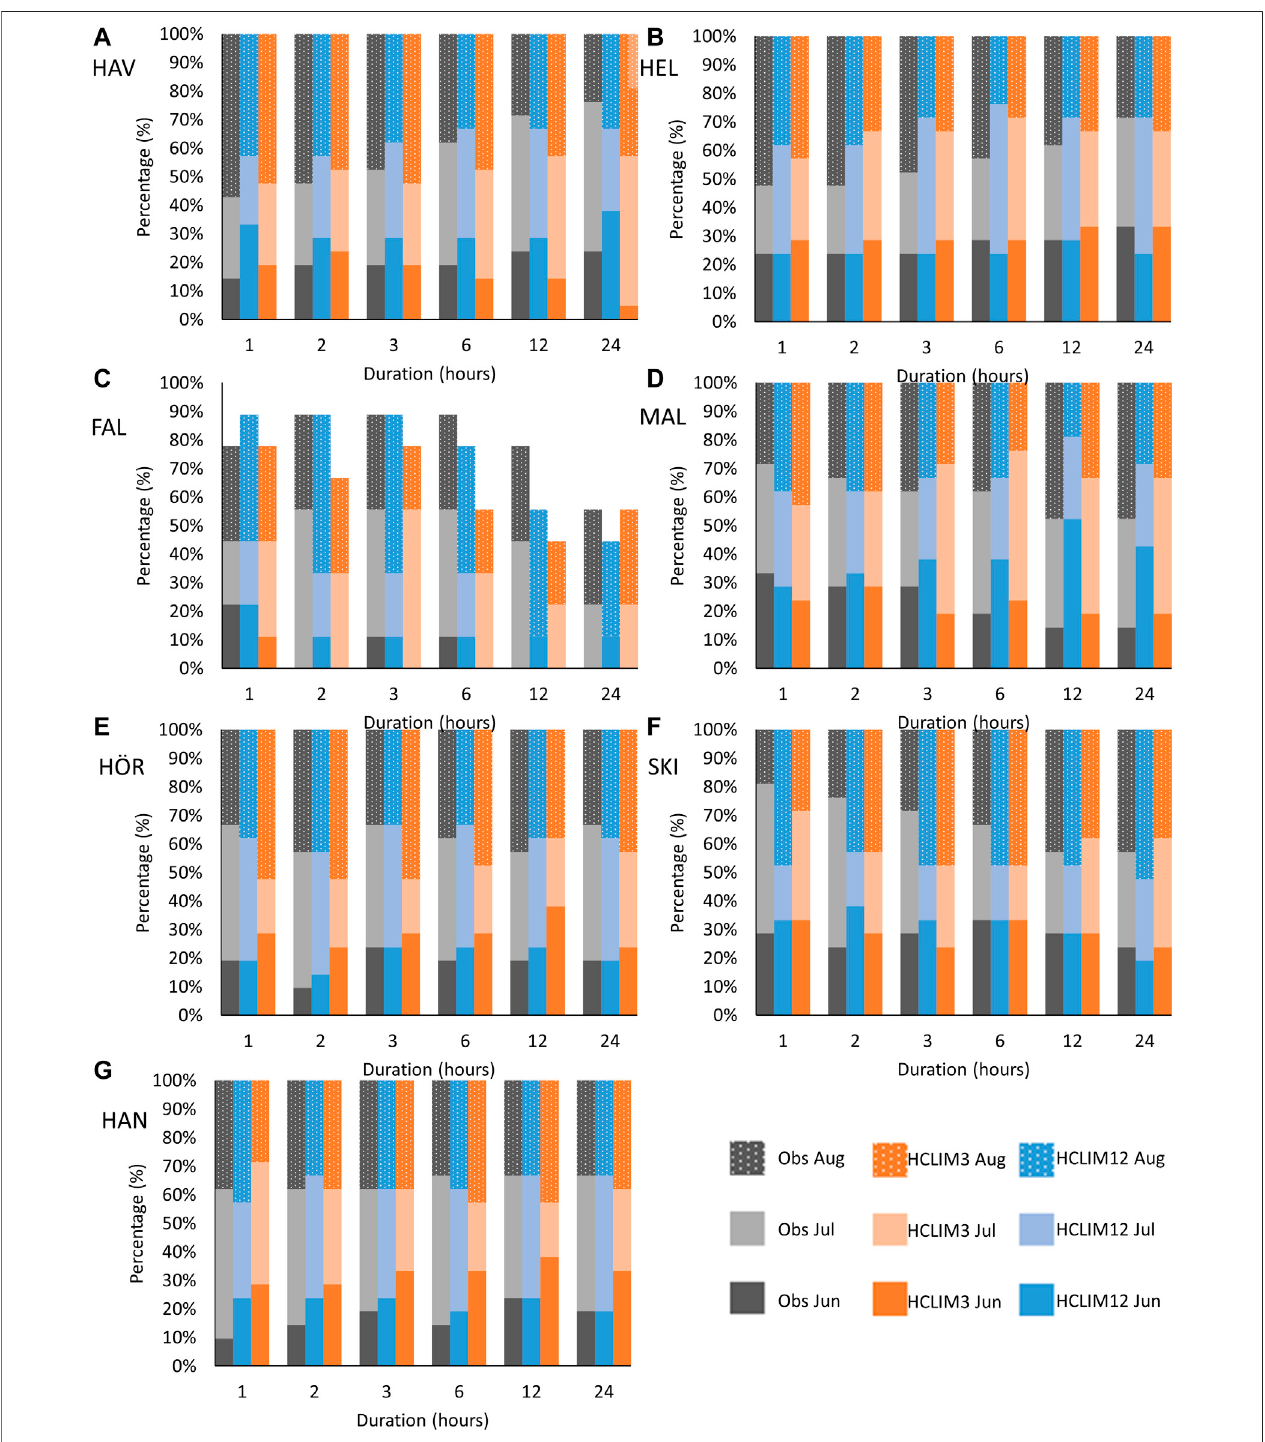
FIGURE 7 | Percentage of annual extremes Perc d max in Jun, Jul and Aug for durations 1, 2, 3, 6, 12, and 24 h in stations HAV (A) , HEL (B) , FAL (C) , MAL (D) , HÖR (E) , SKI (F) and HAN (G) .